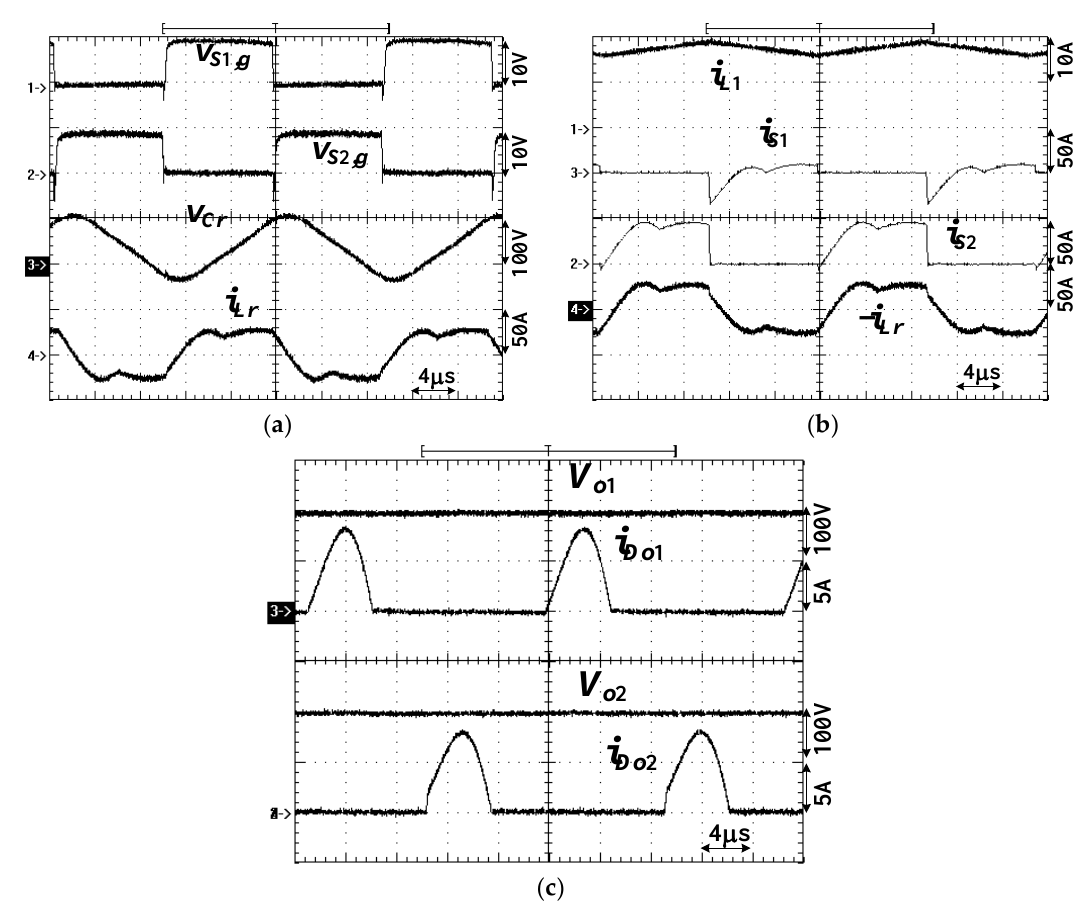
Figure 10. Test waveforms at V in = 41 V and rated power: ( a ) v S 1 , g , v S 2 , g , v Cr , i Lr ; ( b ) i L 1 , i S 1 , i S 2 , − i Cr ; ( c ) i Do 1 , i Do 2 , V o 1 , V o 2 .